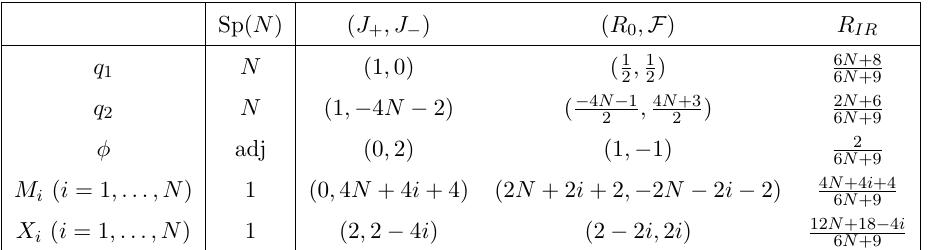
Table 1 . Matter content of the N = 1 gauge theory, which (cid:13)ows to the ( A 1 ; A 2 N ) Argyres-Douglas theory. The ( J + ; J (cid:0) ) are two candidate R-charges. The superconformal R-charge R IR = R 0 + (cid:15) F is given by a linear combination of the two, which is determined via a -maximization. From this we obtain (cid:15) = 6 N +7 . The last column denotes the superconformal R-charge at the IR (cid:12)xed 6 N +9